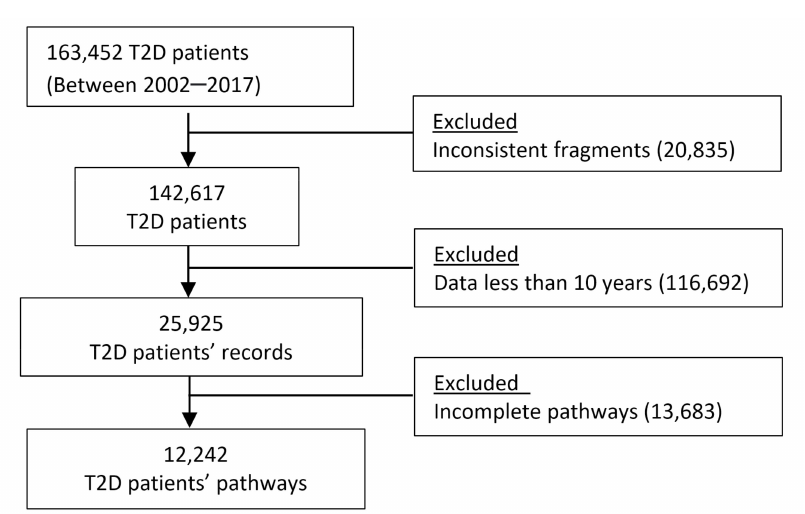
Figure 5. Process of identifying eligible patients’ pathways in analysis. Abbreviation: T2D, type 2 diabetes